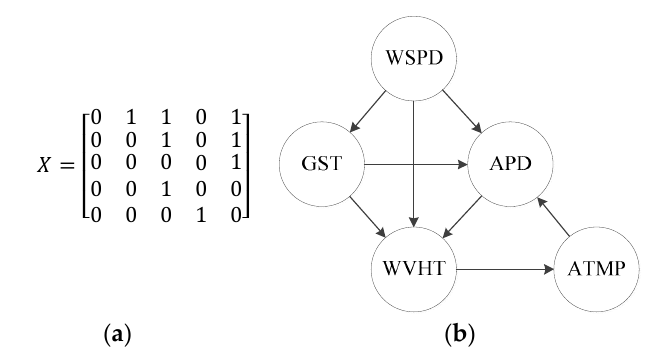
Figure 5. IF between different variables.